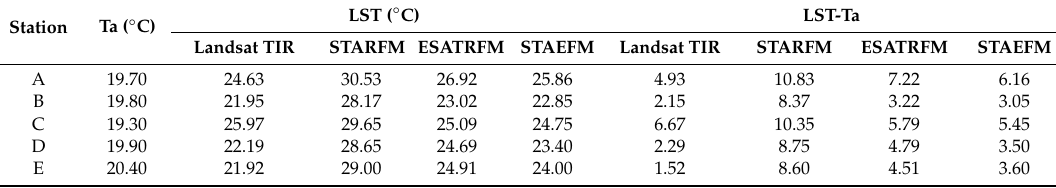
Table 3. Comparison of LST with air temperature from meteorological